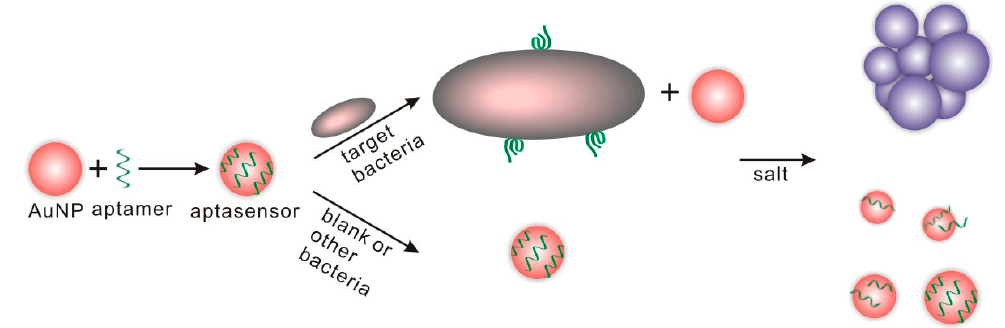
Figure 4. Colorimetric detection of bacteria using aptamers and AuNPs (adapted with permission from [41]).